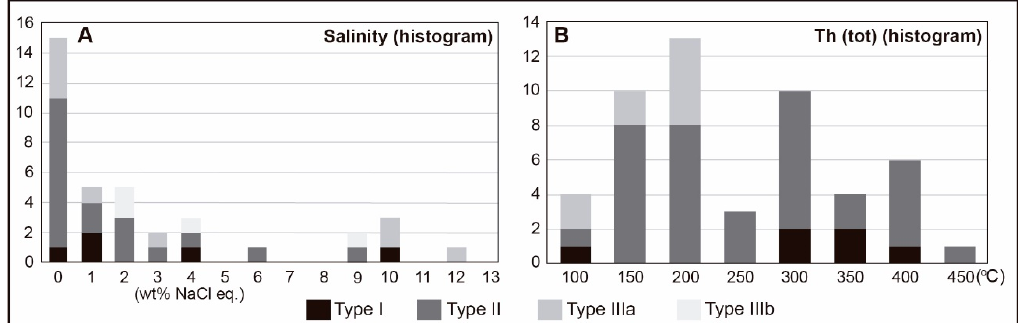
Figure 18. Frequency diagram of ( A ) salinities and ( B ) T h -tot of the fluid inclusion types studied in the Passa Três deposit.